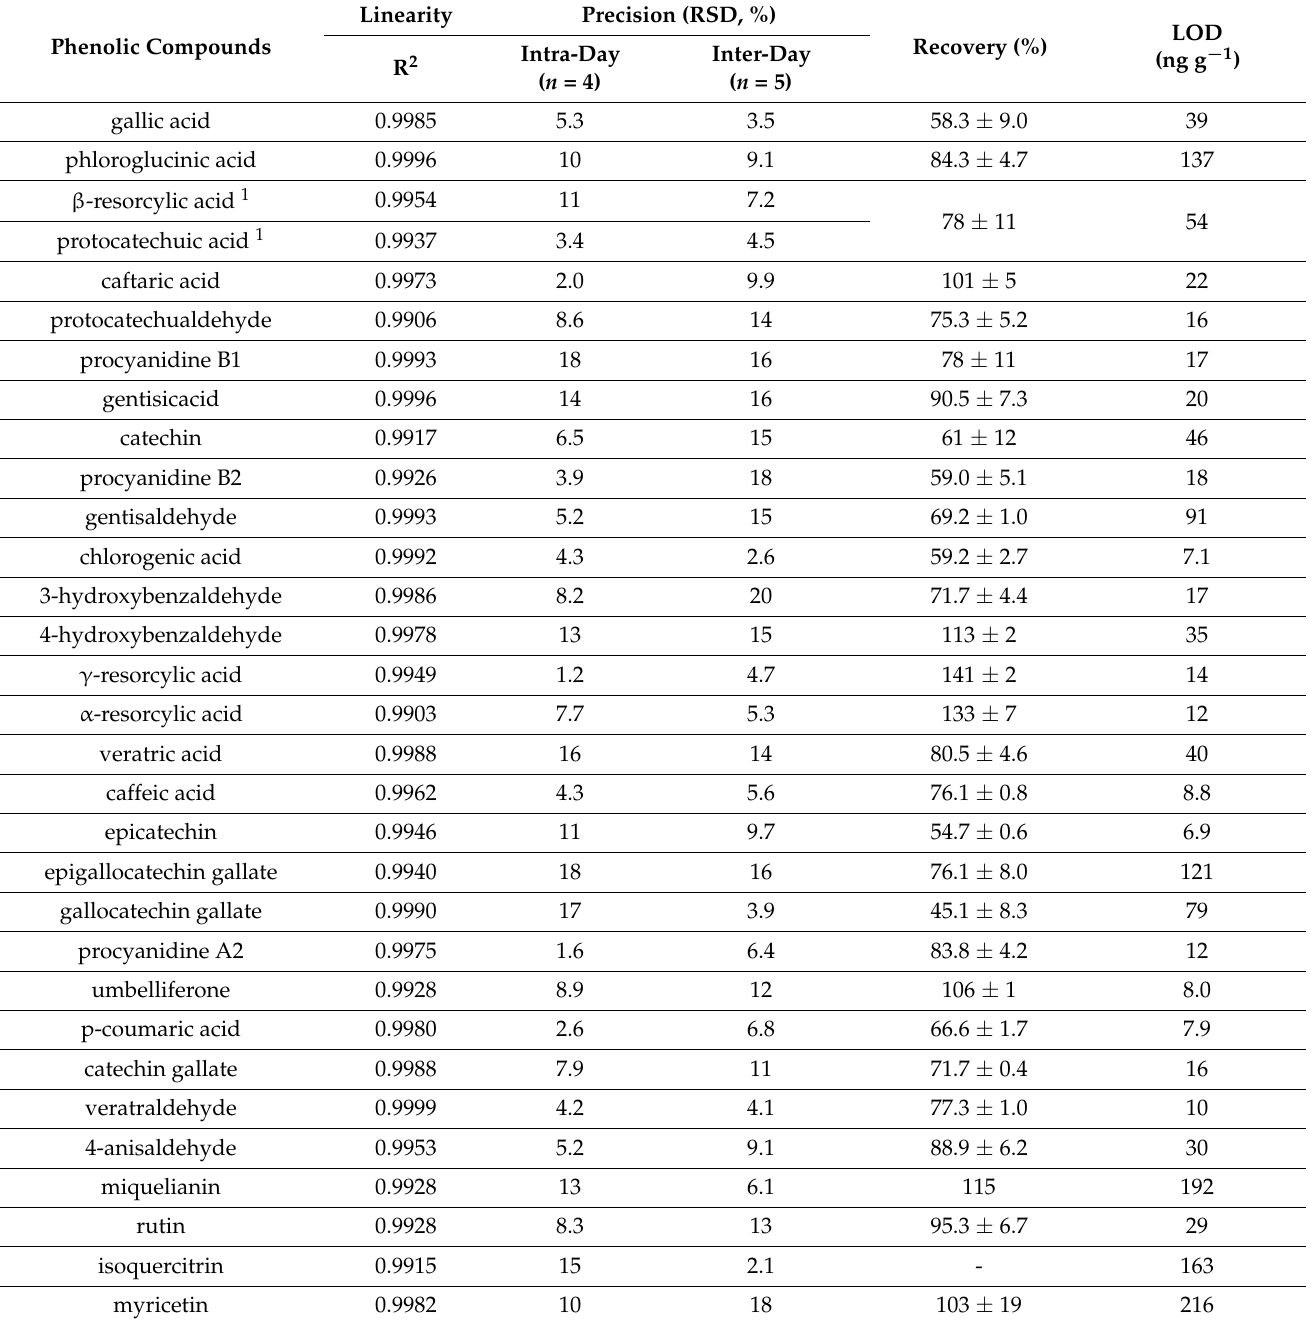
Table 2. VE-UAE_LC-MS/MS performance: Linearity, precision, recoveries and